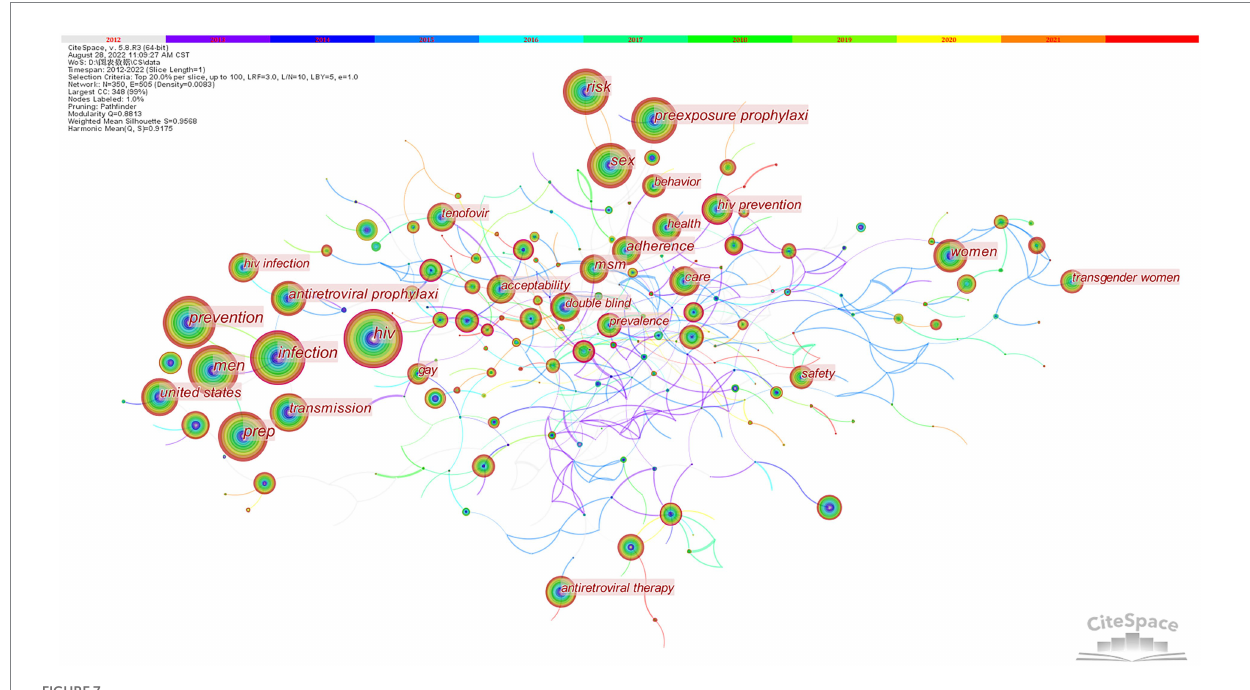
FIGURE 7 The network map of keywords.